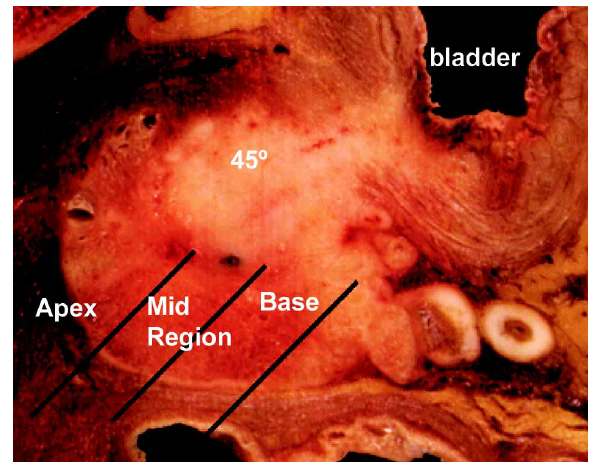
Figure 2 – Sagittal section of the prostate, showing the localiza- tion of punctures (authorized by Sanofi-Synthelabo).